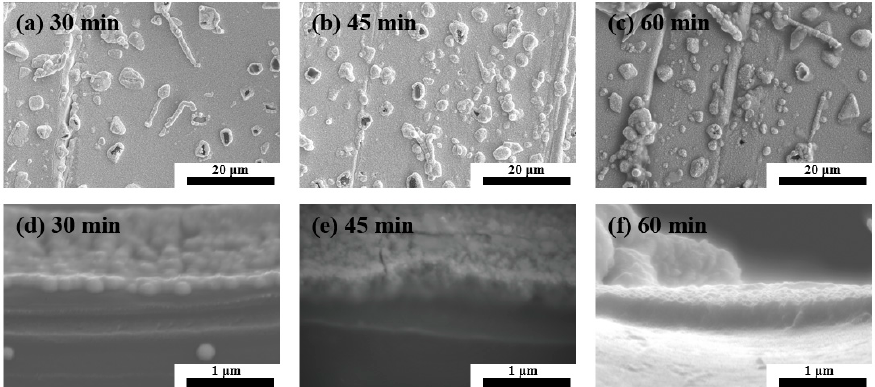
Figure 3. Surface morphology of Pt metallized PET treated by the sc-CO 2 catalyzation followed by ( a ) 30 min, ( b ) 45 min and ( c ) 60 min of the Pt deposition time, and cross-sectional view of the specimen with ( d ) 30 min, ( e ) 45 min and ( f ) 60 min of the Pt deposition time. The thickness of the Pt layer was determined from the cross-sectional images. Exam-